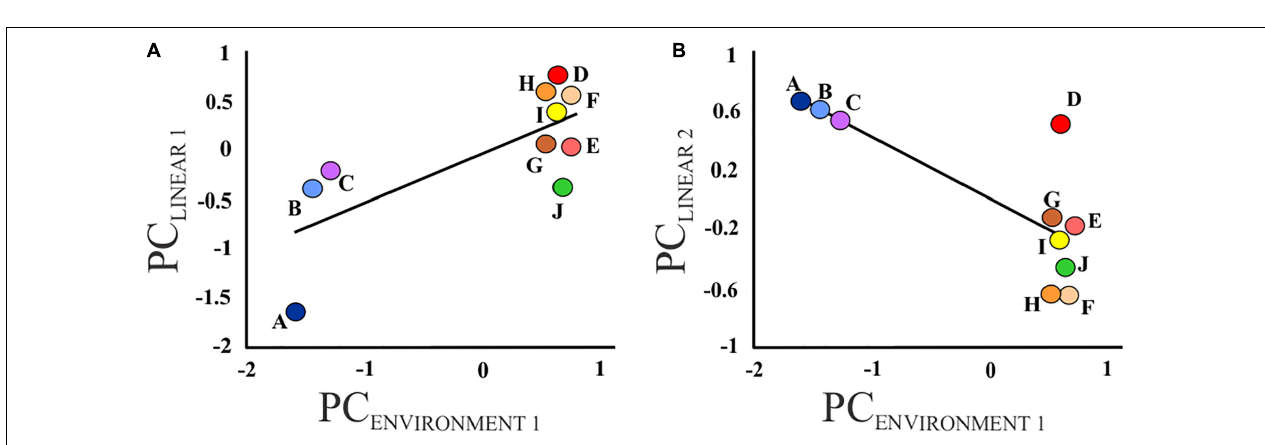
FIGURE 3 | Graphs illustrating the mean and standard deviation for each locality with regards to (A) PC SHAPE 1 (dorsal-ventral redistribution), (B) PC SHAPE 2 (rounded bodies, shortened caudal peduncle), (C) PC LINEAR 1 (body depth), and (D) PC LINEAR 2 (gape size). Different alphabetical letters above the bars indicate values with statistically significant differences (Bonferroni post hoc test; P < 0.05), while identical letters indicate no significant differences among means. The fish outline drawings on the left of graph (A,B) depict the variation in fish body shape for PC SHAPE 1 and PC SHAPE 2 , respectively. The light blue line representing the average shape for all fish, while the dark blue line represents the upper and lower body shape extremity (scale factor set to 0.08 and – 0.08, respectively).